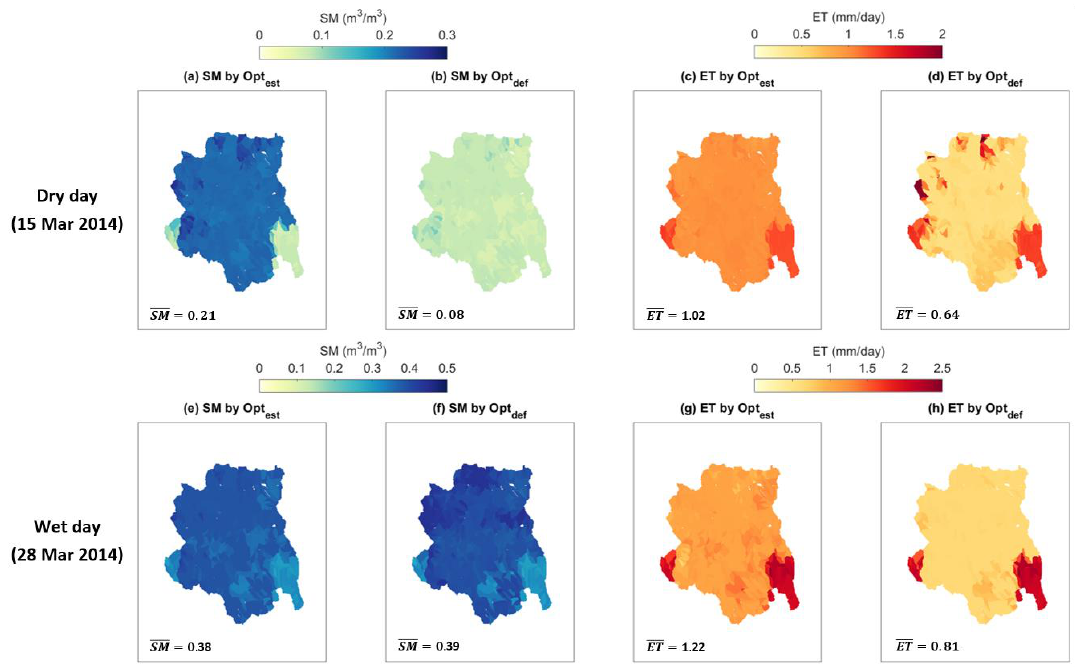
and Opt in dry ( a – d , 15 March 2014) est def